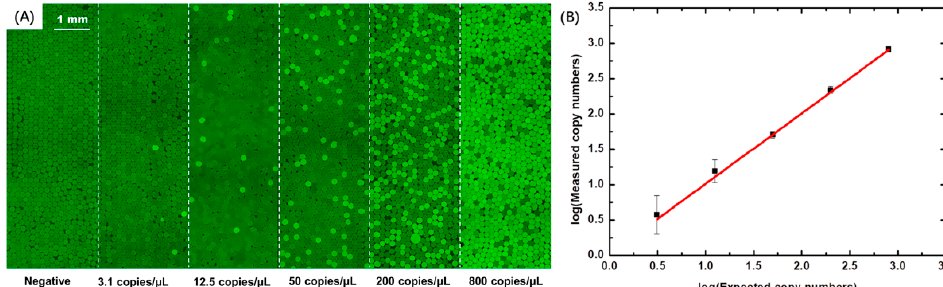
Figure 5. Digital PCR performed for K-RAS using the CBbE approach. ( A ) Single-layer droplet fluorescence images of droplet-based digital PCR. Dark green indicates negative droplets and light green indicates positive droplets. ( B ) Comparison of measured and expected copy numbers. The measured copy numbers were obtained by analysis of more than 5000 droplets using Poisson statistics, with each data point corresponding to three independent digital PCR measurements. The expected copy numbers were estimated from qPCR measurements. The solid red line is a linear fit (R 2 > 99.2%). Error bars given are standard deviations (SD).